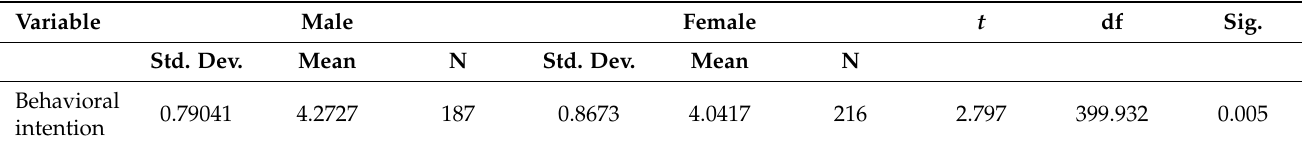
Table 8. t -test of the respondents’ behavioral intention attributed to